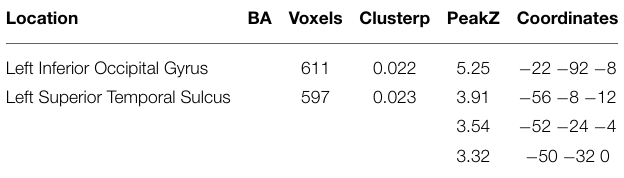
TABLE 4 | Regions activated by a main effect of Type (CP vs.